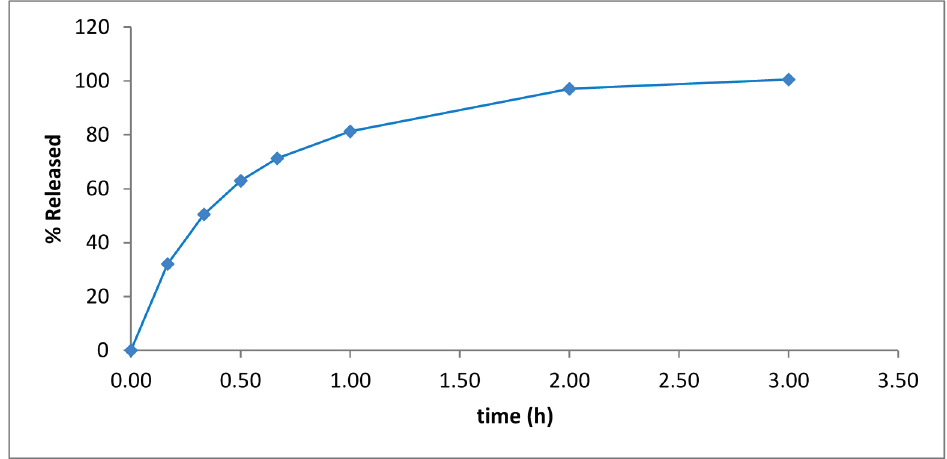
Figure 10. Release of Pilocarpine from ViscoGel™ in PBS at 37